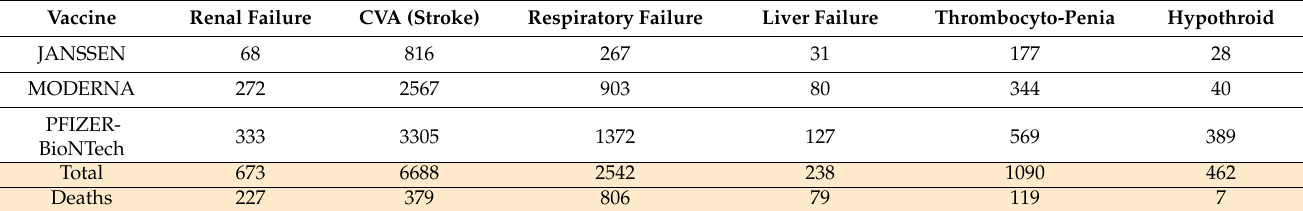
Table 3. Other major adverse events post-COVID-19